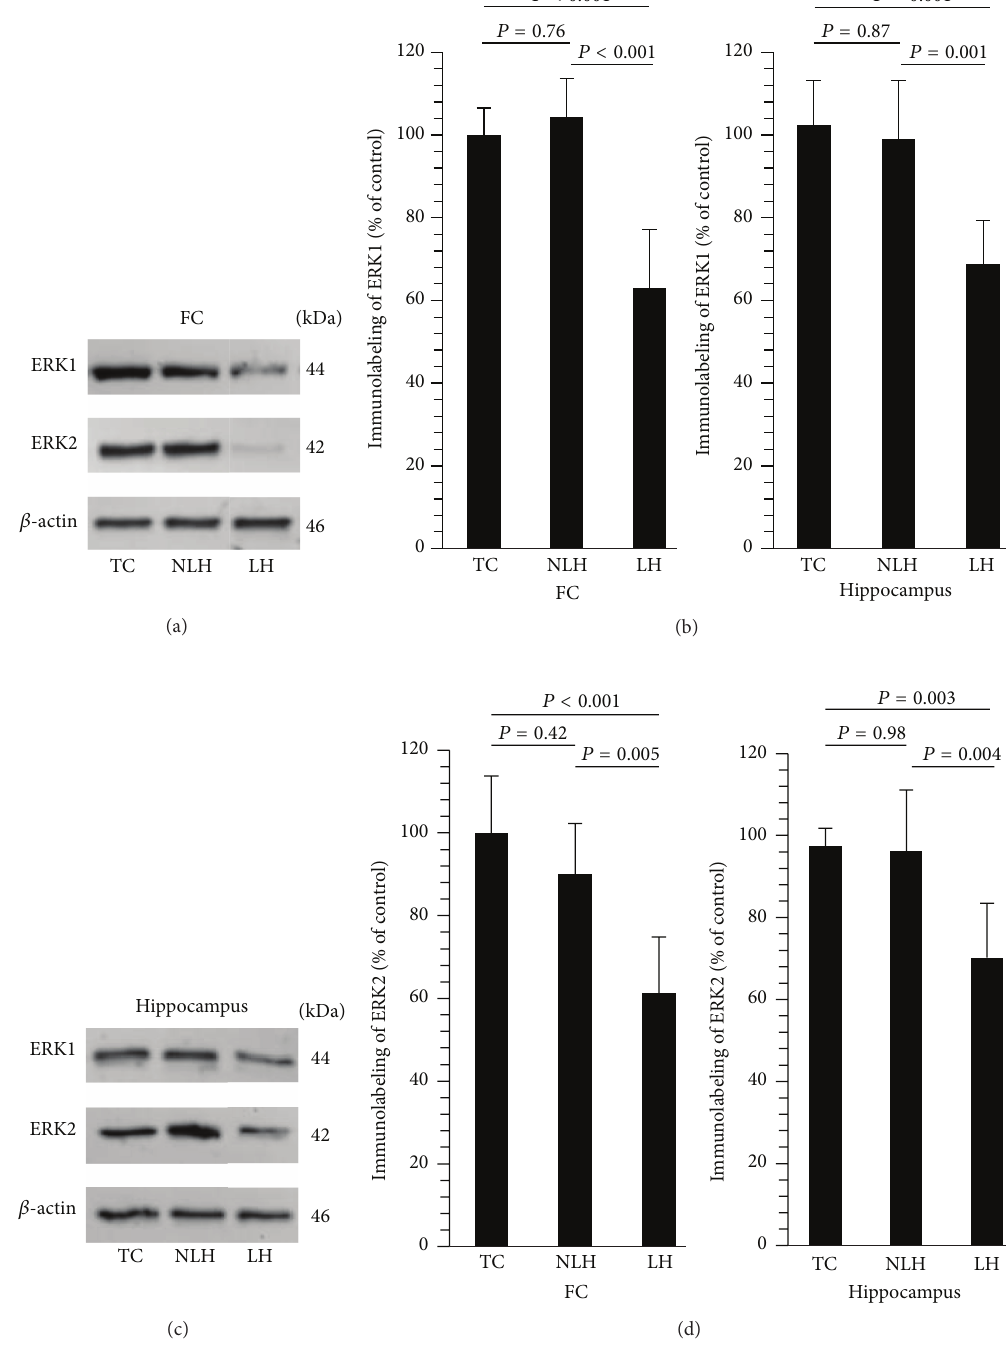
Figure 3: Western blots showing immunolabeling of ERK1 and ERK2 in frontal cortex (FC) (a) and hippocampus (b) of tested control (TC), non-NLH (NLH), and learned helpless (LH) rats. 𝛽 -actin was used as endogenous control and a ratio of optical density of ERK1 and ERK2 to the optical density of the corresponding 𝛽 -actin was calculated. (b) Mean ± SD of protein expression levels of ERK1 and ERK2 in FC (c) and hippocampus (d) of TC, non-LH, and LH rats ( 𝑛 = 6 /group). Overall group differences in the 3 groups are as follows. ERK1: FC, df = 2,15 , 𝐹 = 28.10 , and 𝑃 < 0.001 ; hippocampus, df = 2,15 , 𝐹 = 14.35 , and 𝑃 < 0.001 . ERK2: FC, df = 2, 15 , 𝐹 = 14.09 , and 𝑃 < 0.001 ; hippocampus, df = 2, 15 , 𝐹 = 10.16 , and 𝑃 < 0.002